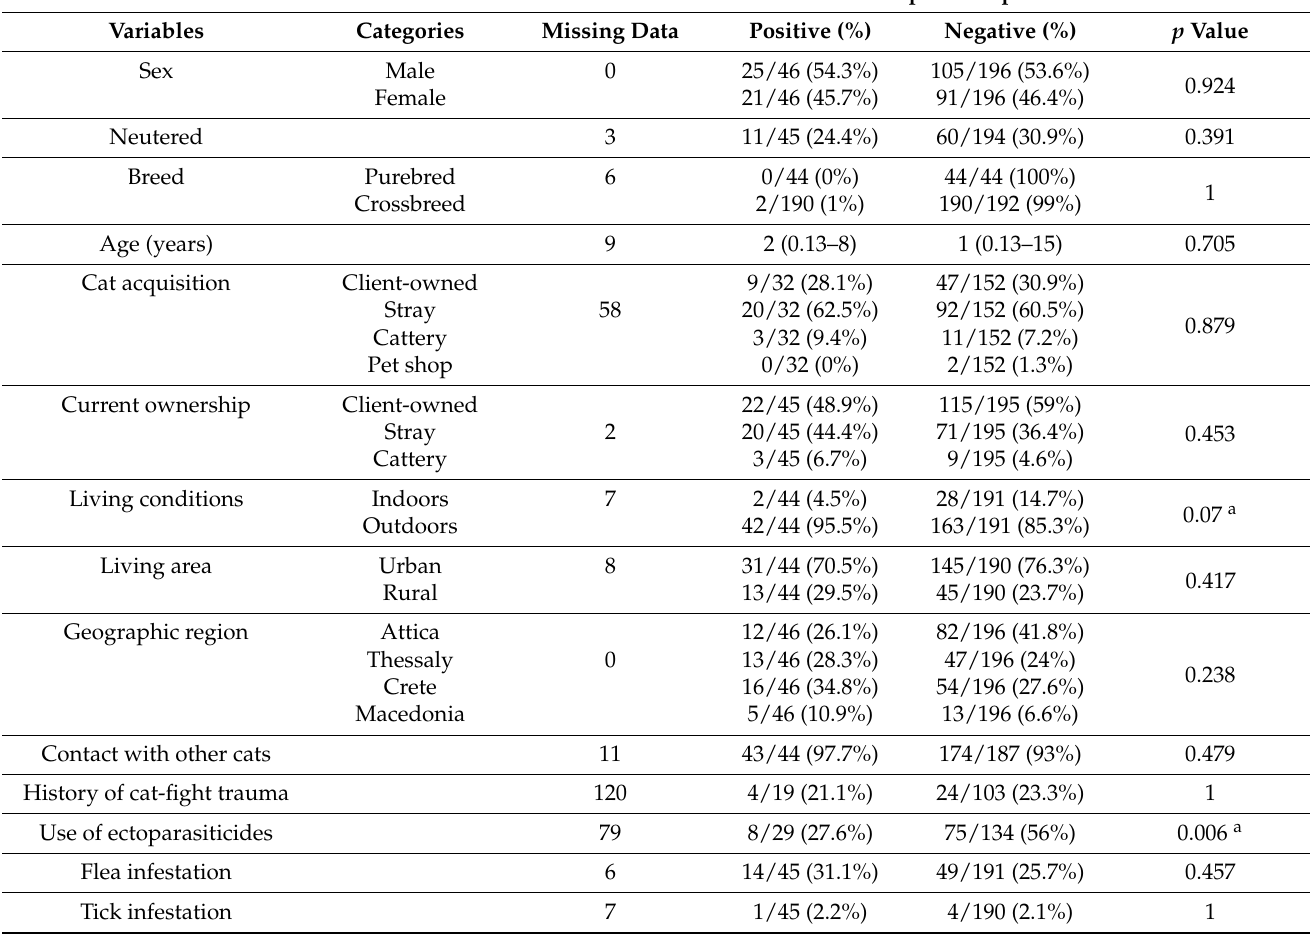
Table 4. Univariable associations between the infection status of 242 cats tested for haemoplasma species by PCR and the signalment and historical data that were collected using a standardised questionnaire (Questionnaire